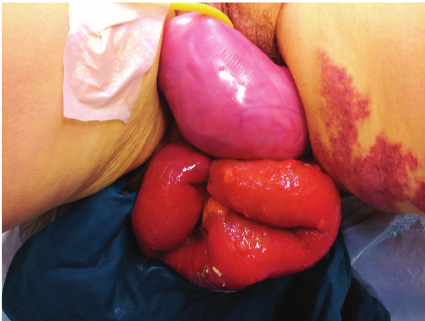
Figure 1: Small bowel loops prolapsing through a dehiscence of the vaginal